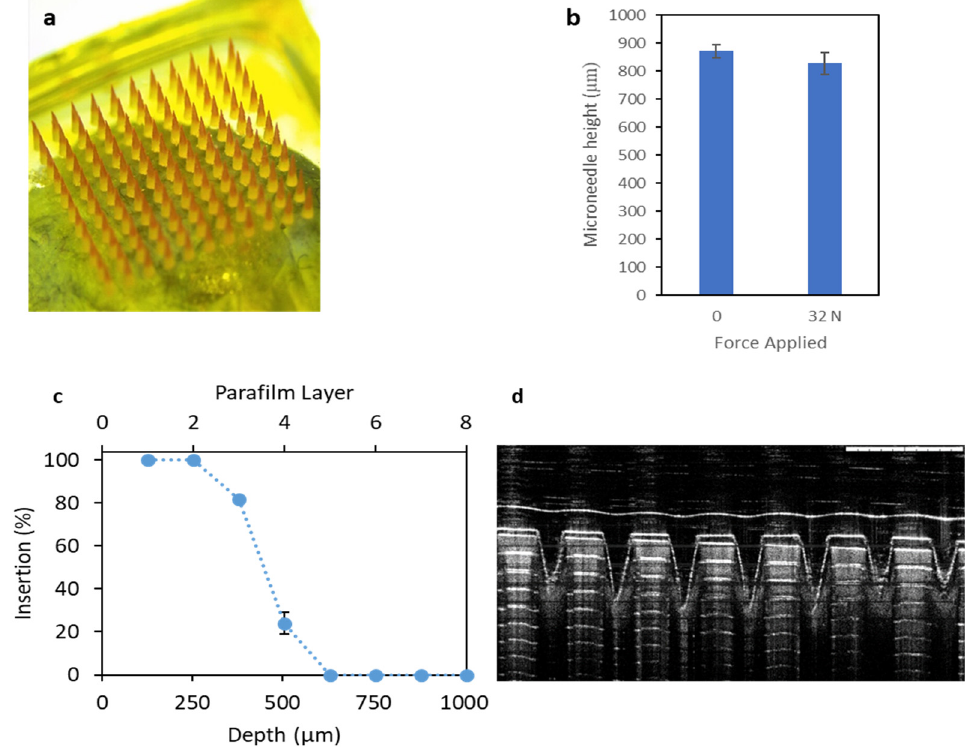
Figure 6. ( a ) Panoramic light microscope image of CU-MN; ( b ) CU-MN height before and after application of 32 N force for 30 s (means + S.D., n = 3); ( c ) insertion depth and number of Parafilm M ® layers perforated during CU-MN application (means ± S.D., n = 3) and ( d ) optimal cutting temperature (OCT) image of perforated Parafilm M ® after CU-MN application (Scale bar = 1 mm).